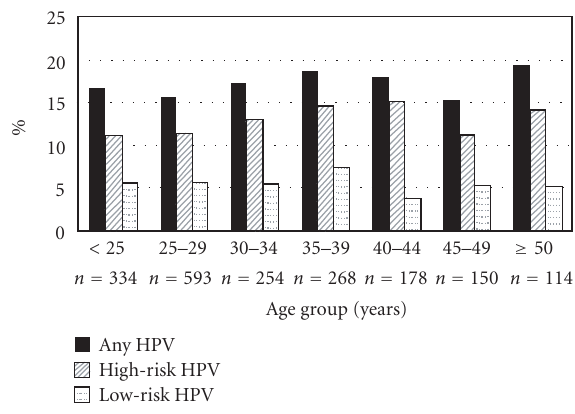
Figure 2: Age distribution of oncogenic HPV types in an Indian population